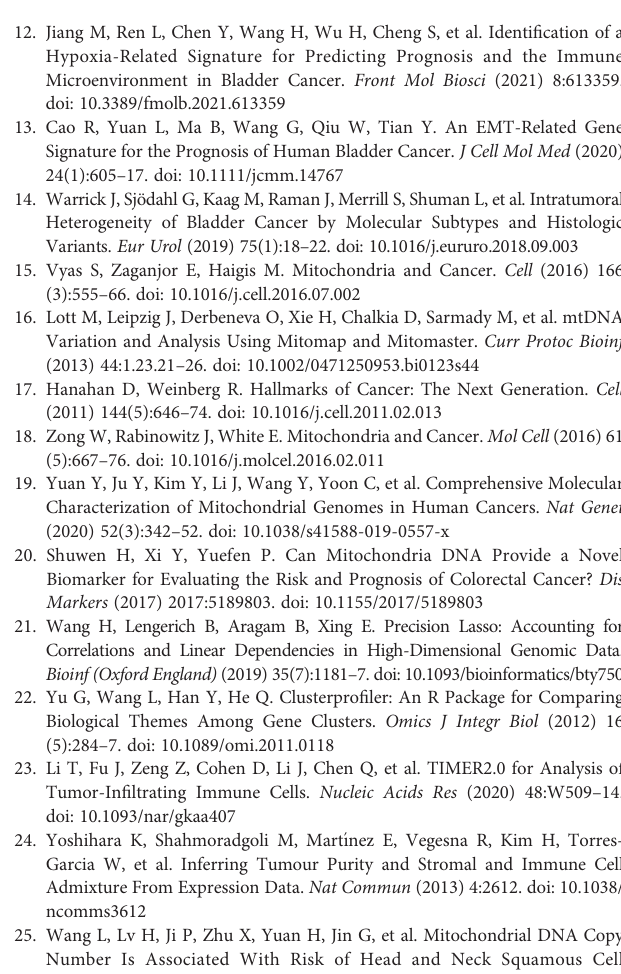
Supplementary Figure S1 | Comparison of the mRNA expression data (only signi fi cantly differential expressed genes were shown, *p < 0.05) between BLCA patients and normal people samples from the TCGA cohort. Supplementary Figure 2 | cBioPortal oncoprints of the nuclear MTRGs expression pro fi le (A) , the mutation pro fi le (B) , and the copy number alteration pro fi le (C) in each BLCA patient from the TCGA. Supplementary Figure S3 | Comparison of ROC curves for OS at 1-, 3-, 5-year between the nuclear MTRGs score and each single MTRG from the signature. Supplementary FigureS4 | (A,B) Comparisonof the nuclear MTRGs score, and the overall survival between the BC patients presented with concomitant prostate cancer or not. (C, D) Survival analysis of the BC patients with high- or low- nuclear MTRGs score among the BC patients with concomitant prostate cancer or not. Supplementary Figure S5 | Survival analysis of the BC patients with high- or low- nuclear MTRGs score in the male and female